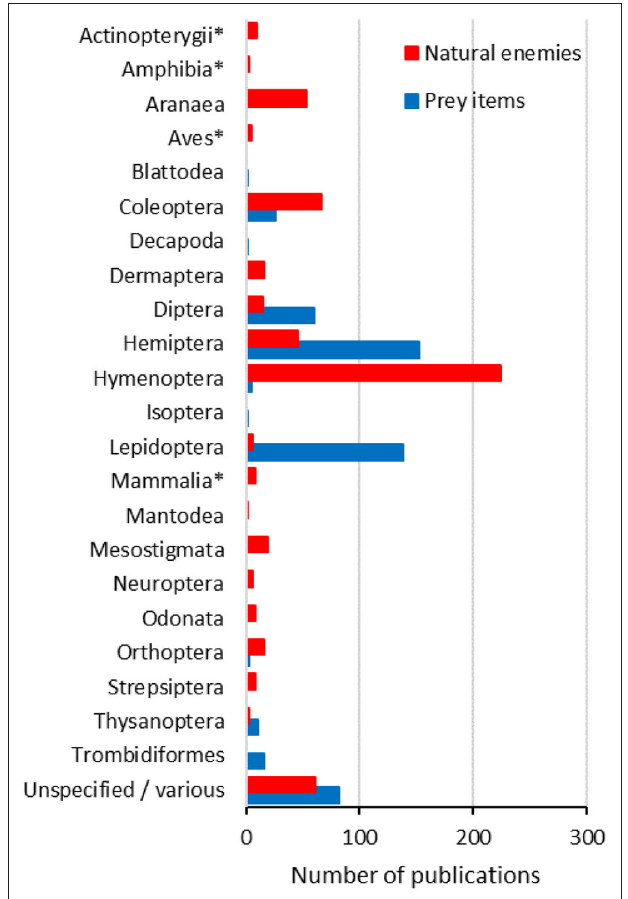
FIGURE 2 | Comparative extent of taxon-level scientific attention to prey items (e.g., herbivorous pests) and natural enemies. Bars represent the number of scientific publications covering a given taxon. Taxa include either consumer (i.e., natural enemy) or resource (i.e., prey) items. Taxa comprise different invertebrate orders within the phylum Arthropoda, while those with an asterisk belong to the phylum Vertebrata.